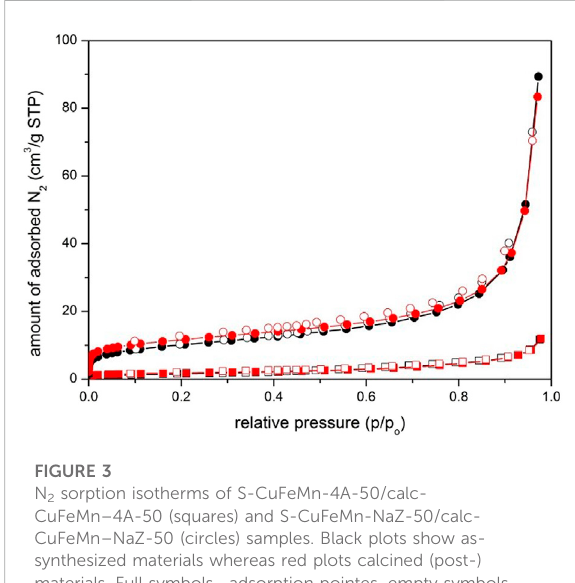
FIGURE 2 X-ray powder diffractograms of zeolite 4A, metal-modi fi ed S-CuFeMn – 4A-50 (brown), calcined metal-loaded sample calc- CuFeMn – 4A-50 (red) and calcined metal-loaded sample after catalytic test postcalc-CuFeMn – 4A-50 (magenta).